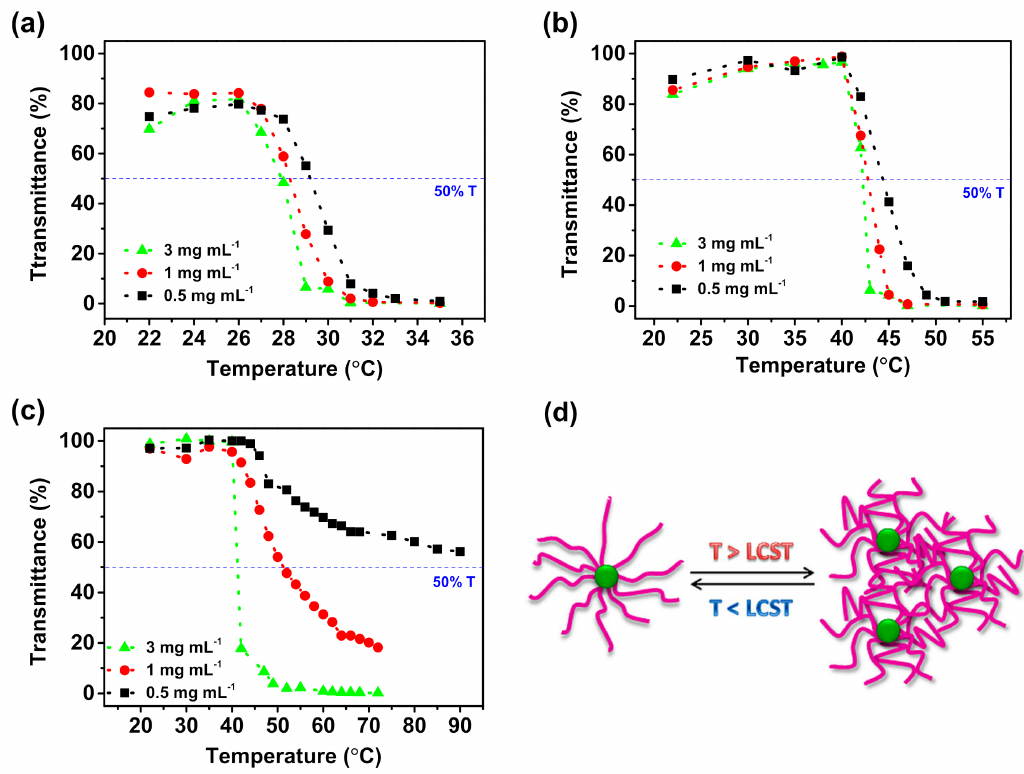
Figure 5. Transmittance at 600 nm for Trox-(PDMAEMA-Br) 10 with ( a ) 49, ( b ) 73, and ( c ) 98 DMAEMA mers in side chains in aqueous solution with varying concentration; ( d ) Scheme of thermoresponsive properties of PDMAEMA-based macromolecules with a troxerutin core. The measurements conducted for the final products from the syntheses shown in Table 1, entry 4 and Table